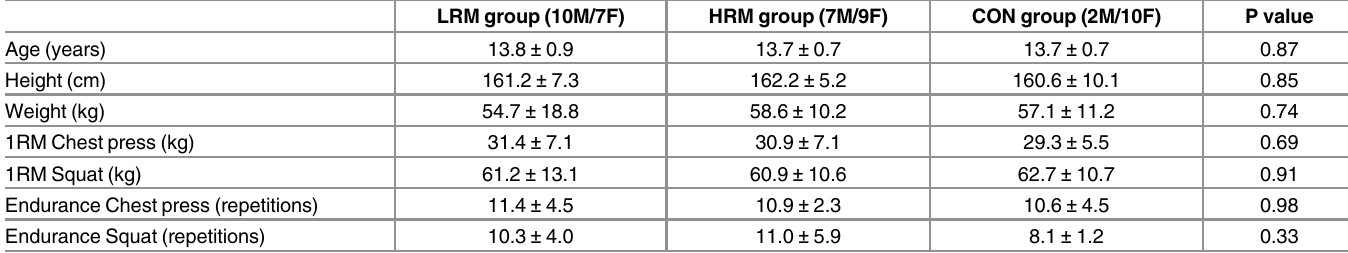
Table 1. Participants ’ physical characteristics of each experimental Group.